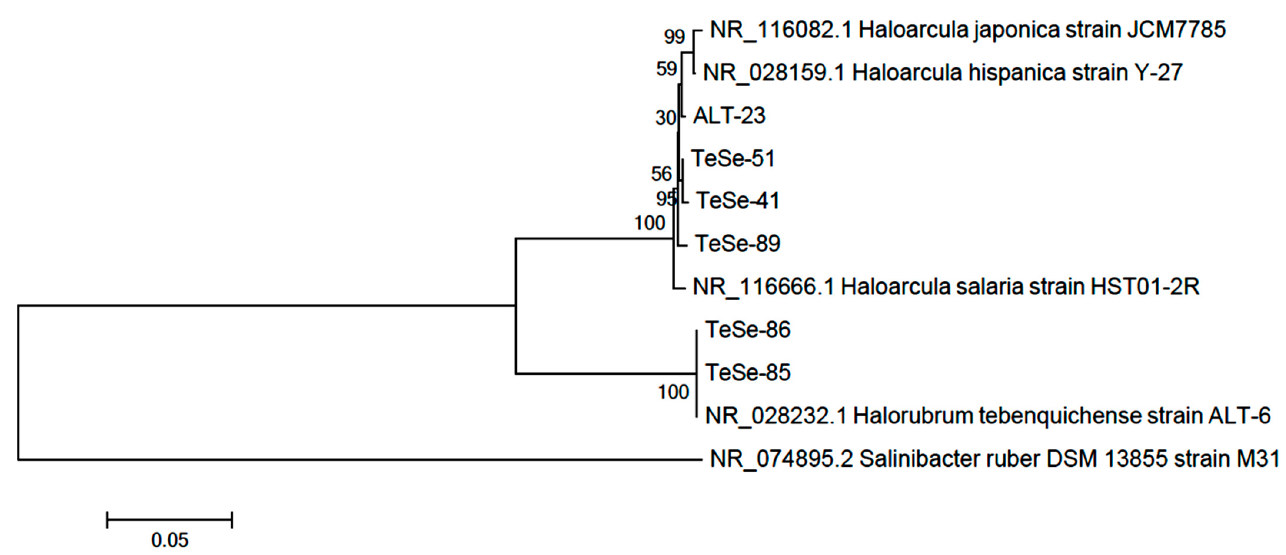
Figure 2. Evolutionary analyses of haloarchaea.